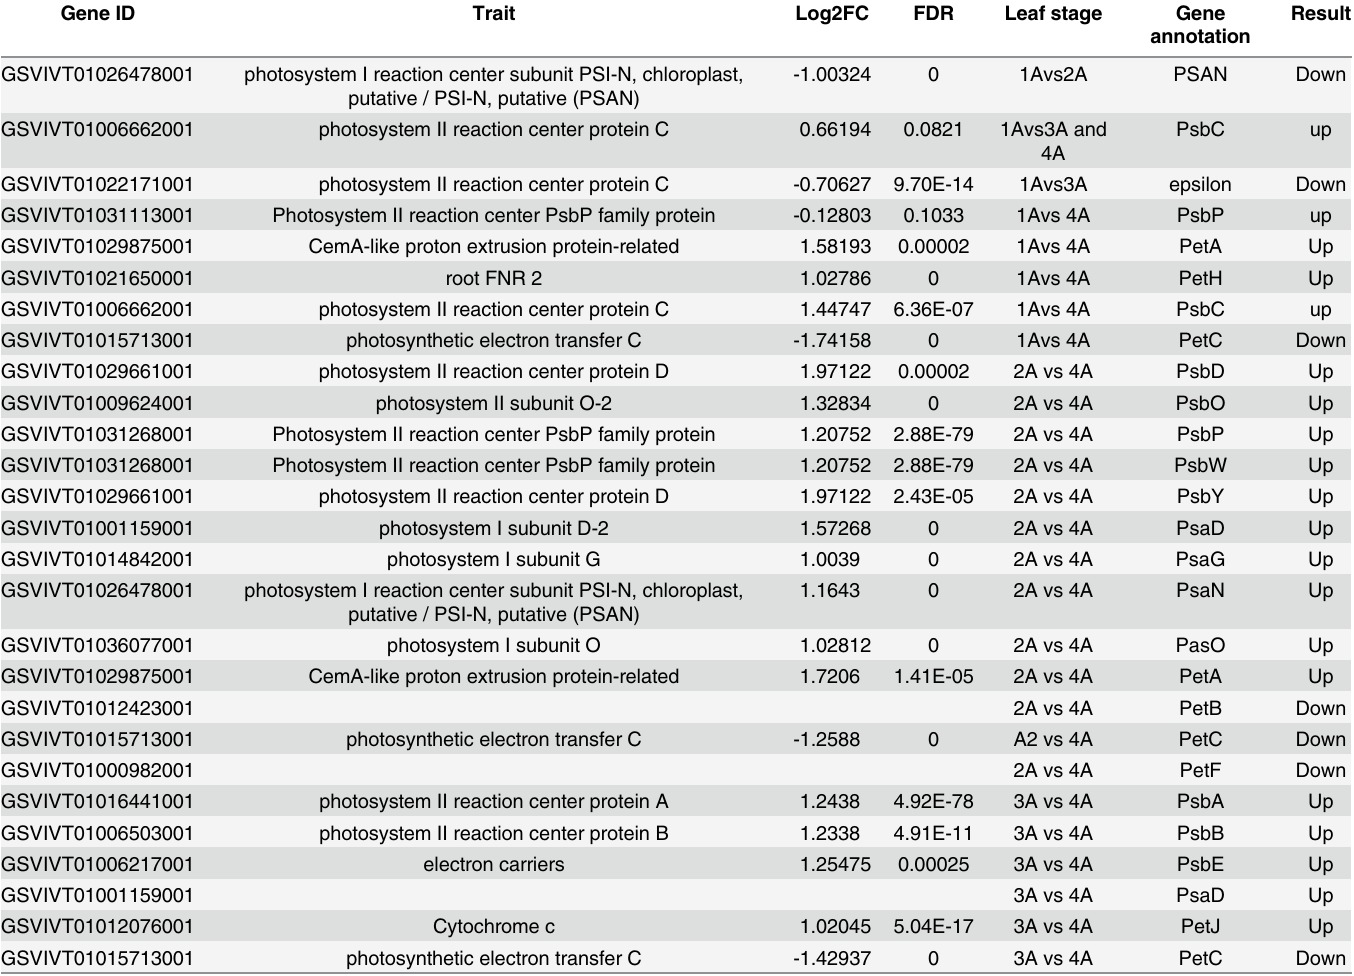
Table 4. Differential expressed genes, related to photosynthesis metabolic pathway. Gene